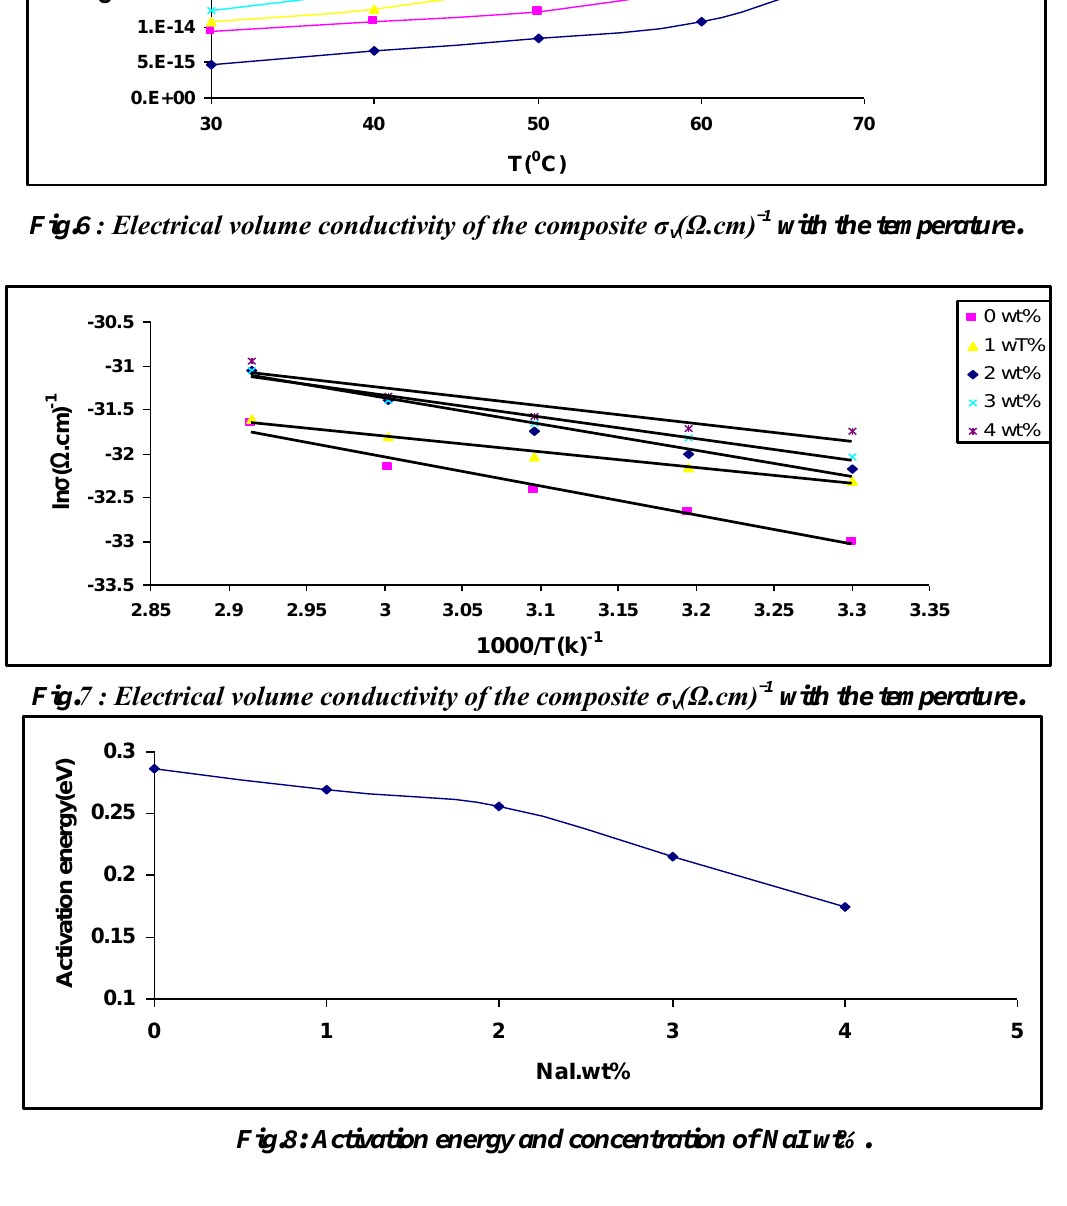
Fig.8: Activation energy and concentration of NaI